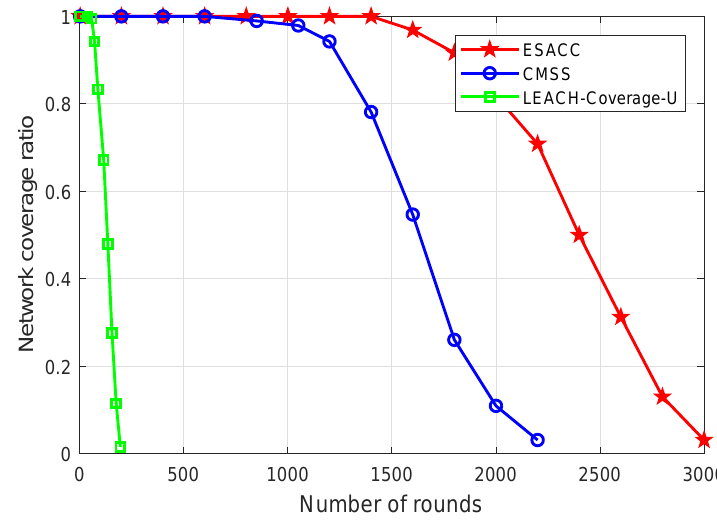
Figure 10. Relationship between network coverage and running